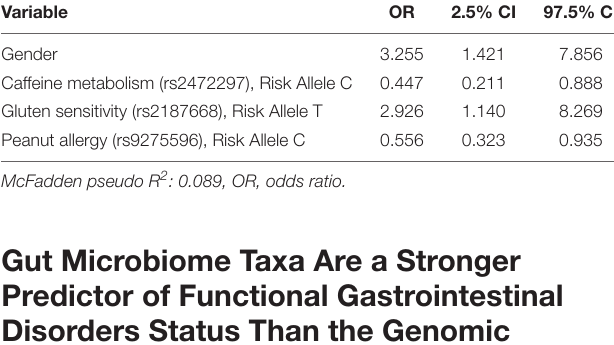
McFadden pseudo R 2 : 0.227, OR, odds